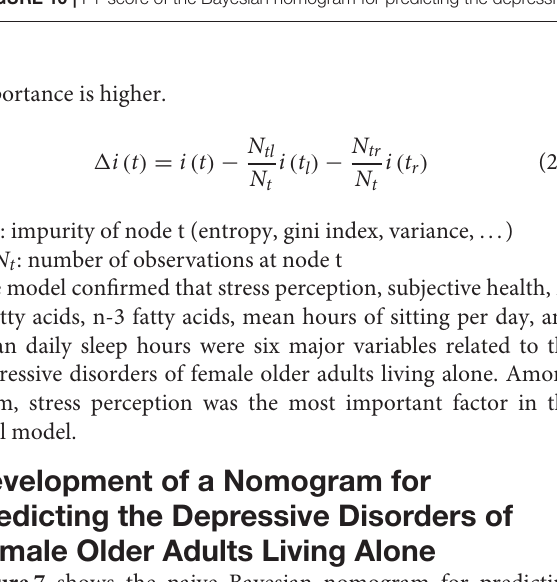
FIGURE 10 | F1-score of the Bayesian nomogram for predicting the depressive disorders of female older adults living alone.